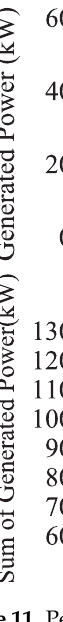
Figure 11. Performance of the proposed control strategy with time-varying load demand. ( a ) Generated power of each DG. ( b ) Incremental cost of each DG. ( c ) Total generated power of all the DGs. ( d ) Average bus voltage of the